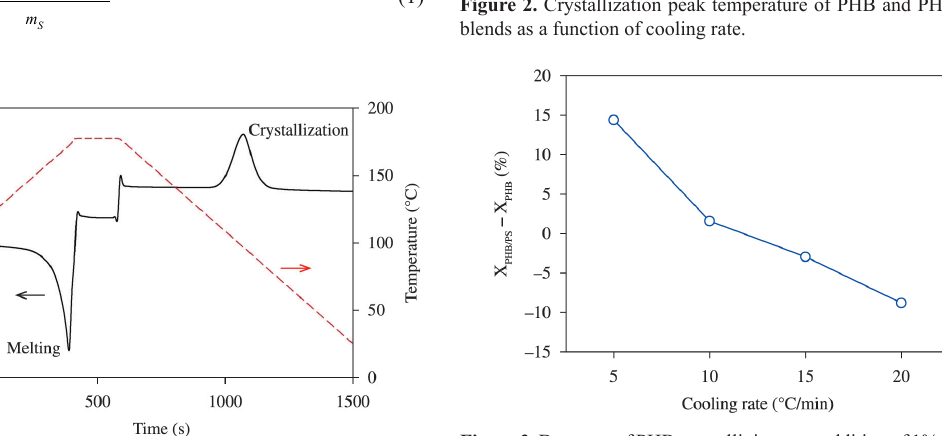
Figure 1. Typical DSC output plot for PHB/PS blend with 1% PS, heated/cooled at 10 °C/min.